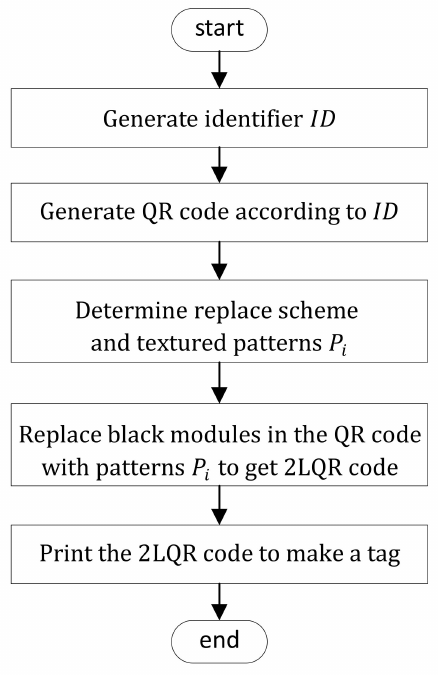
Figure 7. Generation process of the modified 2LQR code